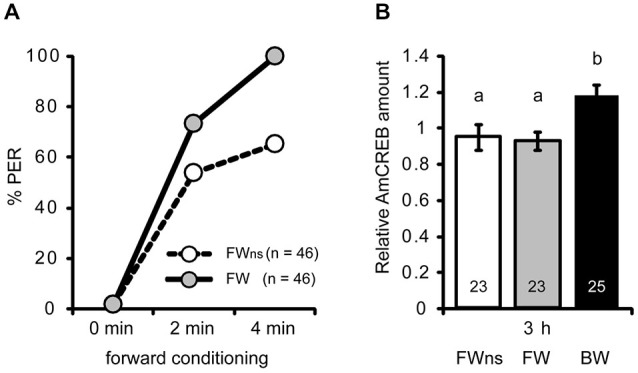
The AmCREB amount depends on the timing of stimulus presentations during conditioning. (A) Honeybees were forward conditioned with three trials. The forward conditioned animals were divided into two groups: one was selected according to a CR in the third trial (FW, gray) and the other remained unselected (FWns, white). A third group received three backward trials (BW, trials not shown). (B) The brains were dissected 3 h after conditioning and analyzed for their relative AmCREB level. The quantification of the relative amount of AmCREB present shows a decreased amount in both forward conditioned groups compared to the backward conditioned bees. One sample consisted of two pooled brains. The numbers in the bars represent the sample size. The groups with unequal letters (a-b) differ significantly. The P-value was corrected due to multiple testing (p < 0.01). Whiskers represent the standard error.